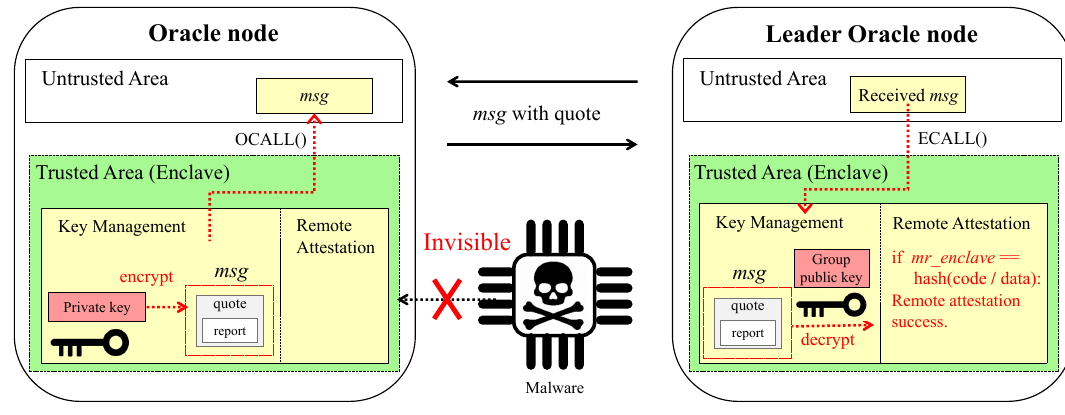
Figure 7. Remote Attestation in